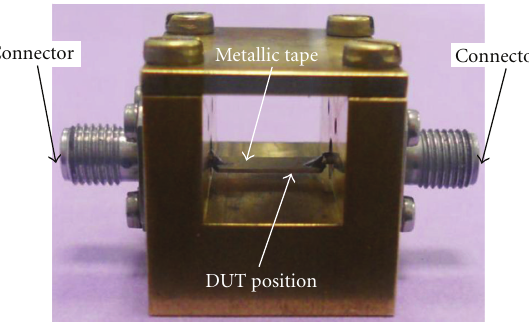
Figure 3: Stripline used for measurements.